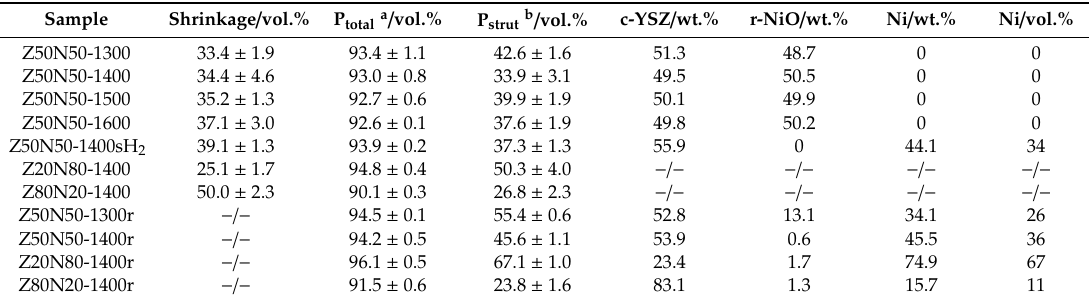
Table 1. Volumetric shrinkage, total porosity (P total ) and strut porosity (P strut ) as well as phase composition of NiO–YSZ and Ni–YSZ composite foams. The phases identified by X-ray di ff raction (XRD) are cubic YSZ, rhombohedral NiO and cubic Ni. Sample